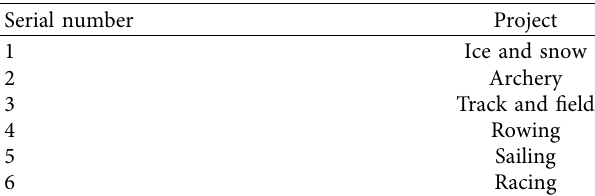
Table 5: Some aspects of graphene composites in